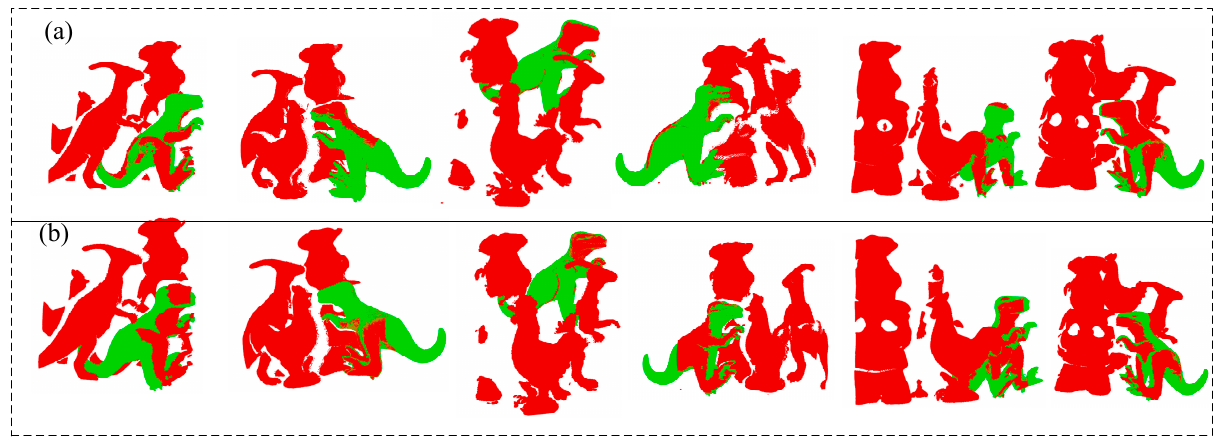
Figure 9. Matching effect display. ( a ) K-PPF; ( b ) PPF.